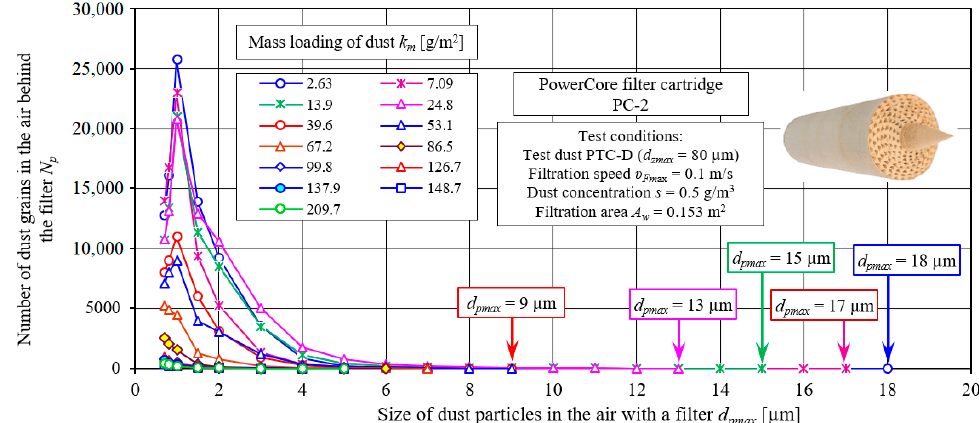
Figure 24. The number of dust grains in the measurement intervals recorded in the air behind the PC-2 filter for successive values of the dust absorption coefficient k m .